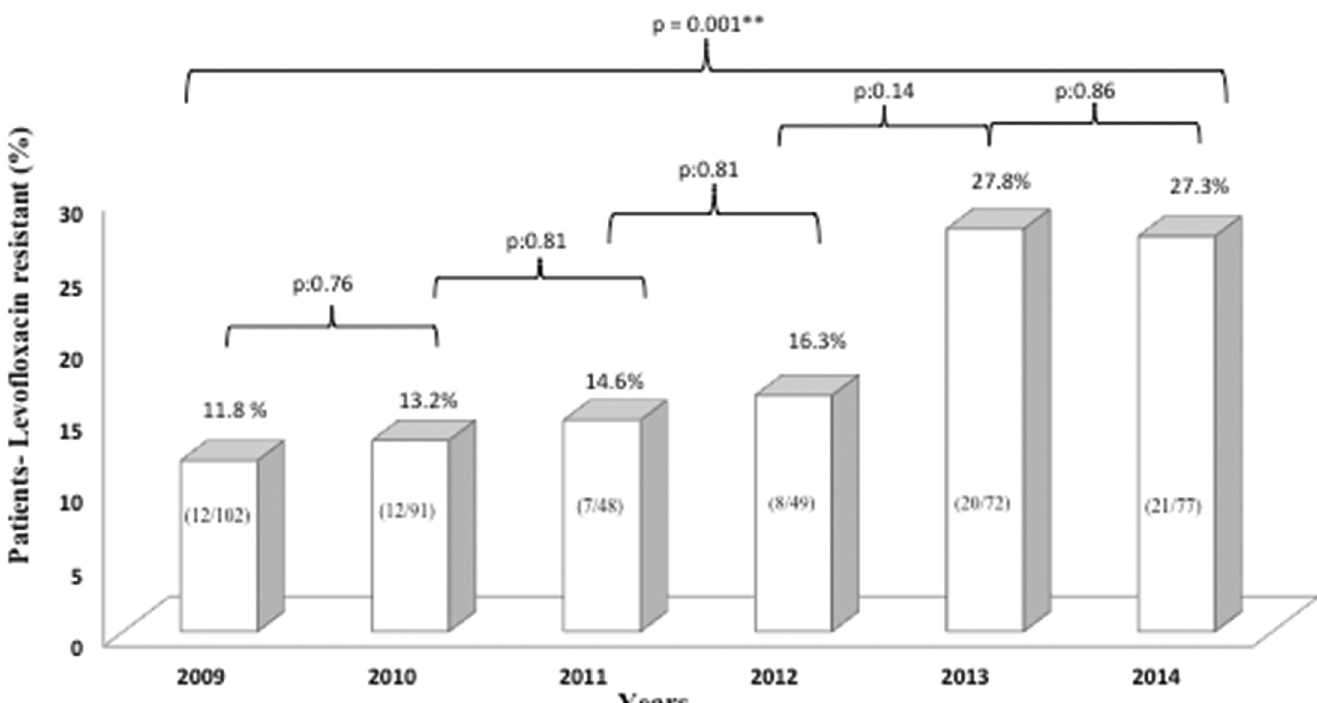
Fig 2. Yearly prevalence. Patients with H . pylori strains resistant to levofloxacin and statistical significance of differences in Bogotá-Colombia; between 2009 and 2014.